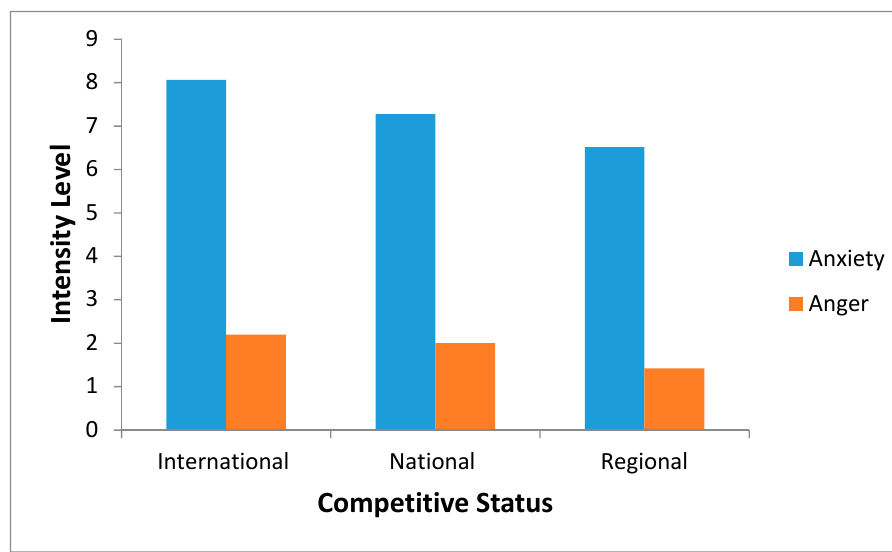
Figure 1. Student-athletes’ reported negative emotions across competitive status. For religion, a similar follow-up between-subject ANCOVAs also showed inter-group differences for only anxiety, F ( 2 , 278 ) = 5.409, p = 0.005, η 2 p = 0.37, anger, F ( 2 , 278 ) = 3.610, p = 0.028, η 2 p = 0.25, and dejection, F ( 2 , 278 ) = 9.915, p = 0.000, η 2 p = 0.67. Specifically, Christian student-athletes reported being less anxious ( M = 6.68) compared to their other counterparts: Muslim ( M = 7.63) and others ( M = 8.51). Similarly, Christian student-athletes reported less anger ( M = 1.54) and dejection ( M = 1.35) than their other religious competitors: Muslim (anxiety- M = 2.10; dejection- M = 1.57) and other (anxiety- M = 2.20; dejection- M = 2.06), respectively (see Figure 2).